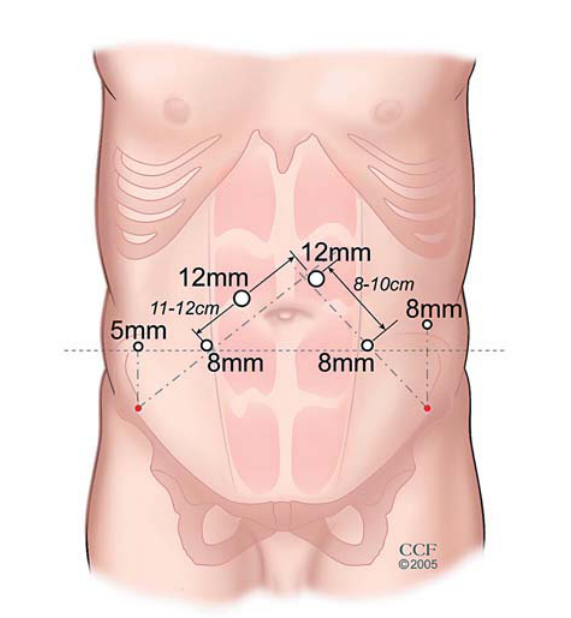
insertion and held by the robotic arm is placed in the periumbilical area. Secondary 8 mm robotic port are placed at the lateral edge at the rectus muscle and an additional robotic 8 mm assistant port is placed in the left lower pelvis as shown. Two assistant ports (12 mm and 5 mm) are placed in the right upper and lower pelvis respectively.